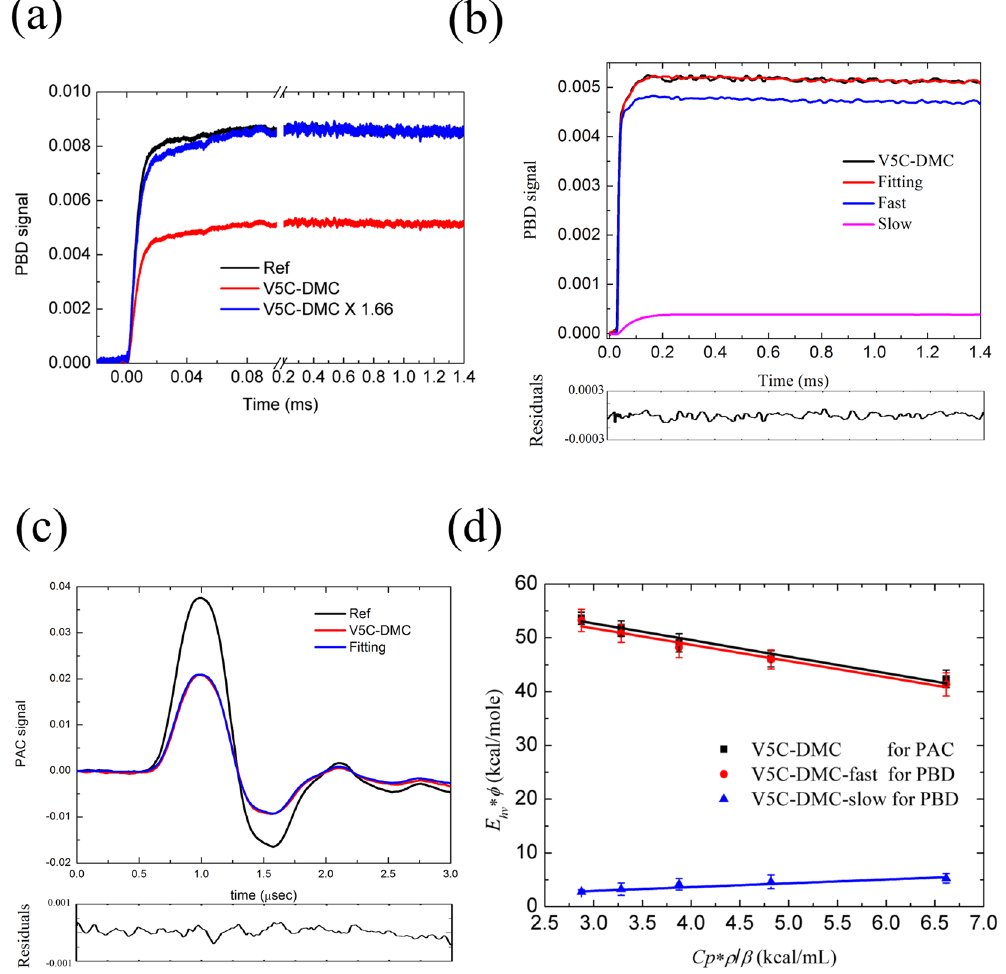
Figure 5. The refolding kinetic data of V5C-DMC after photolysis observed by PAC and PBD. ( a ) The PBD signals of reference (black), V5C-DMC (red) and V5C-DMC multiplied by 1.66 (blue). ( b ) The deconvolution results of PBD signals: V5C-DMC (black), the deconvoluted fast (blue) and slow (pink) events, and the fitting curve (red). ( c ) The PAC signals of reference (black), V5C-DMC (red), the fitting curve (blue). The corresponding residuals of fitting are shown below the plots. ( d ) The plots are of E hv * φ versus C p * ρ / β for the PAC signal ( ■ ), the fast event of PBD signal (V5C-DMC-fast, ● ), and the slow event of PBD signal (V5C- DMC-slow, ▲ ).